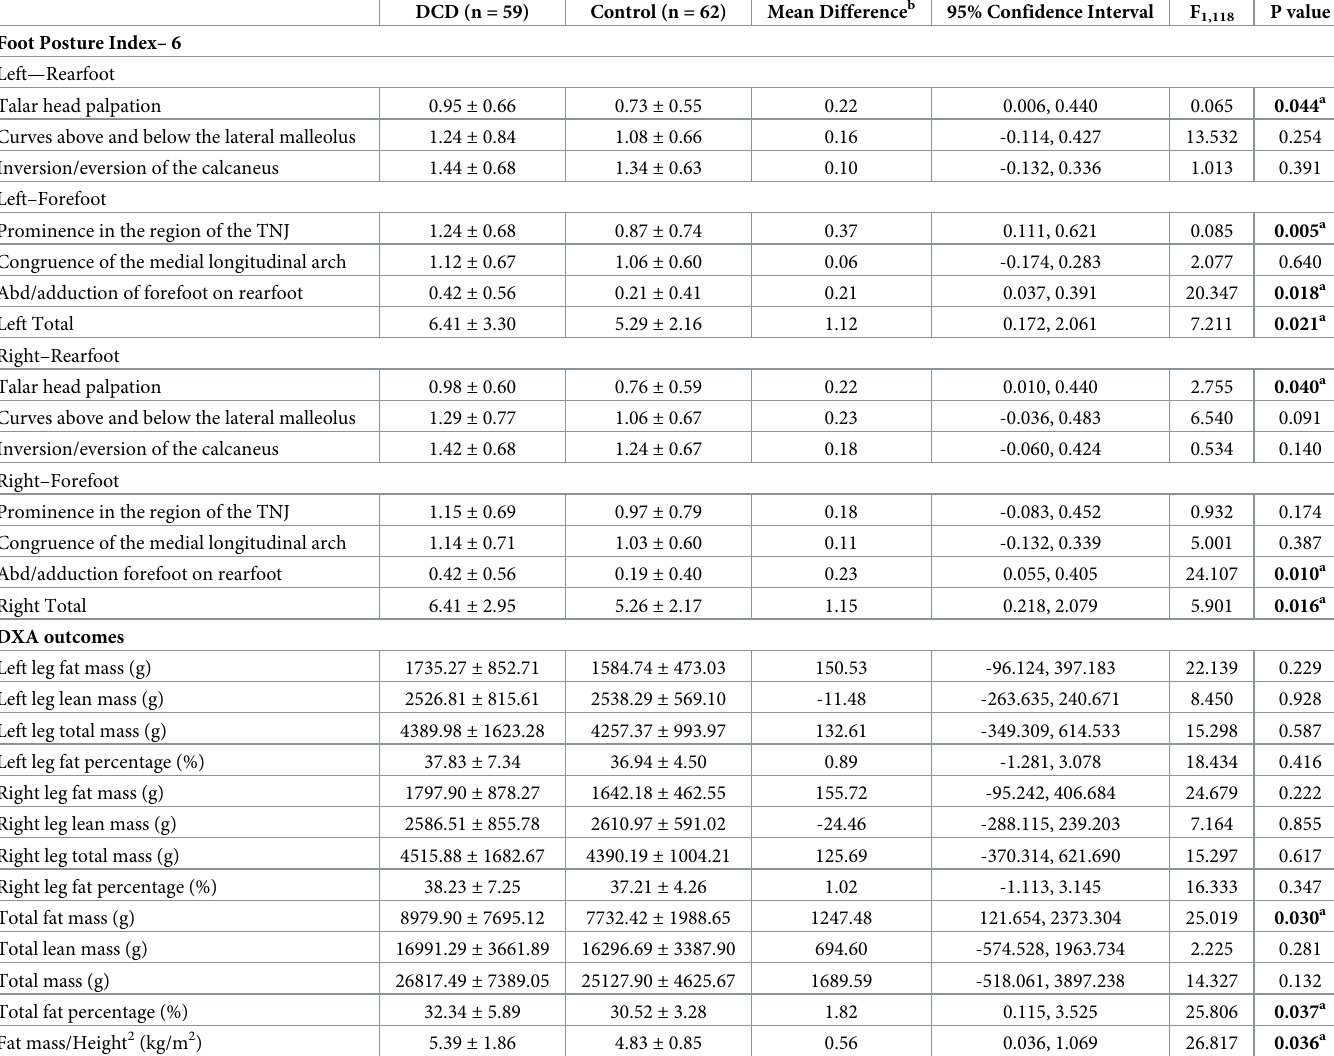
Table 2. Comparison of outcome measures between the DCD group and control